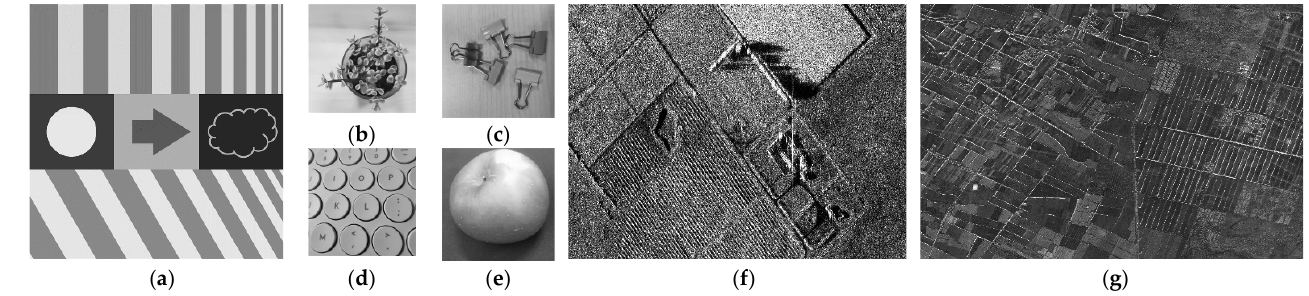
Figure 7. The images for speckle suppression experiments: ( a ) is a computer-generated synthetic image; ( b – e ) are camera pictures for a plant, five clamps, a keyboard, and an apple, respectively; ( f ) is an original single-look Ku band airborne SAR image captured in October 2020; and ( g ) is another original single-look S-band airborne SAR image captured in April 2022. Table 1. Sizes and parameter sets of the proposed method for